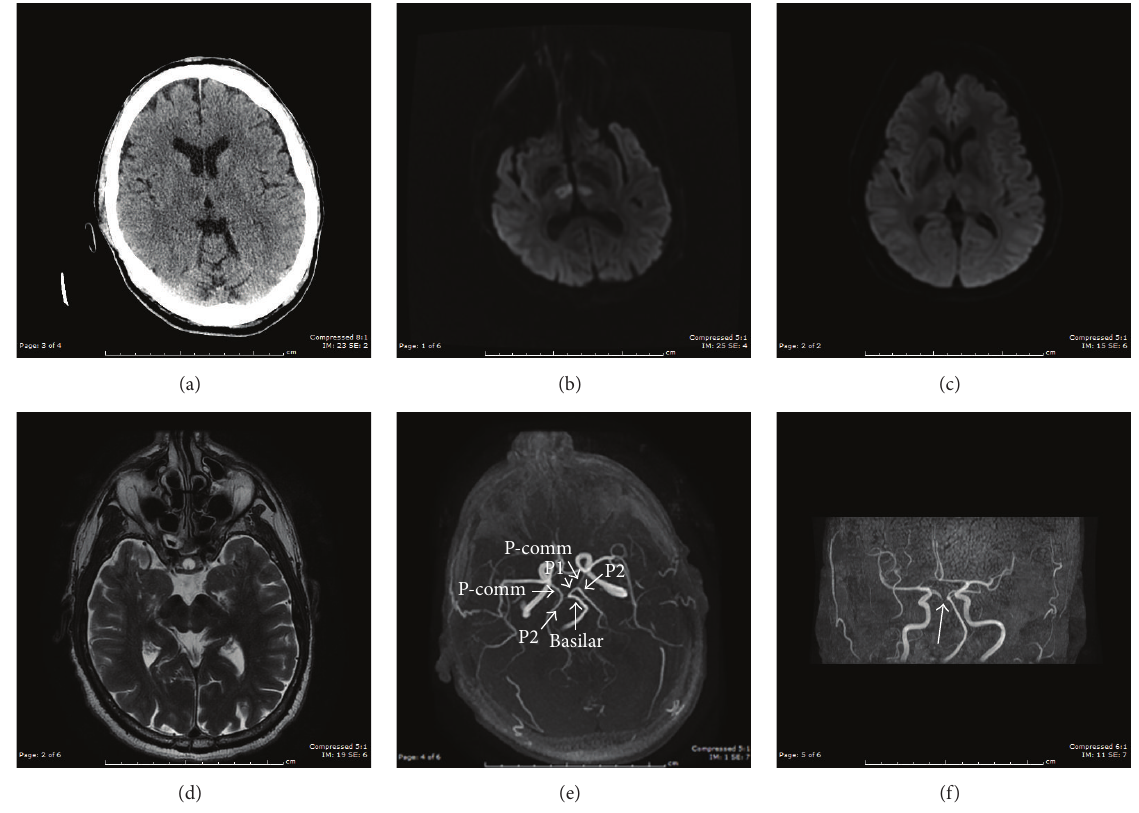
Figure 2: (a) CT head on July 16, 2015, in ER showed bilateral thalamic hypodensities which may represent infarcts; (b) MRI (DWI) on July 16, 2015, showed acute bilateral medial thalamic infarcts, consistent with artery of Percheron territory; (c) MRI (DWI) after two weeks of MICU management on July 31, 2015, showed improved; (d) T2-weighted MRI showed no midbrain involved; (e, f) MRA showed occluded or atretic right P1 segment. The right PCA is patent and supplied by the P-comm. The left PCA is patent.